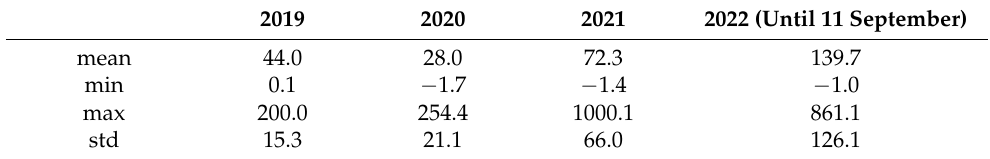
Table 1. Mean, minimum, maximum, and standard deviation of electricity price by year ( €